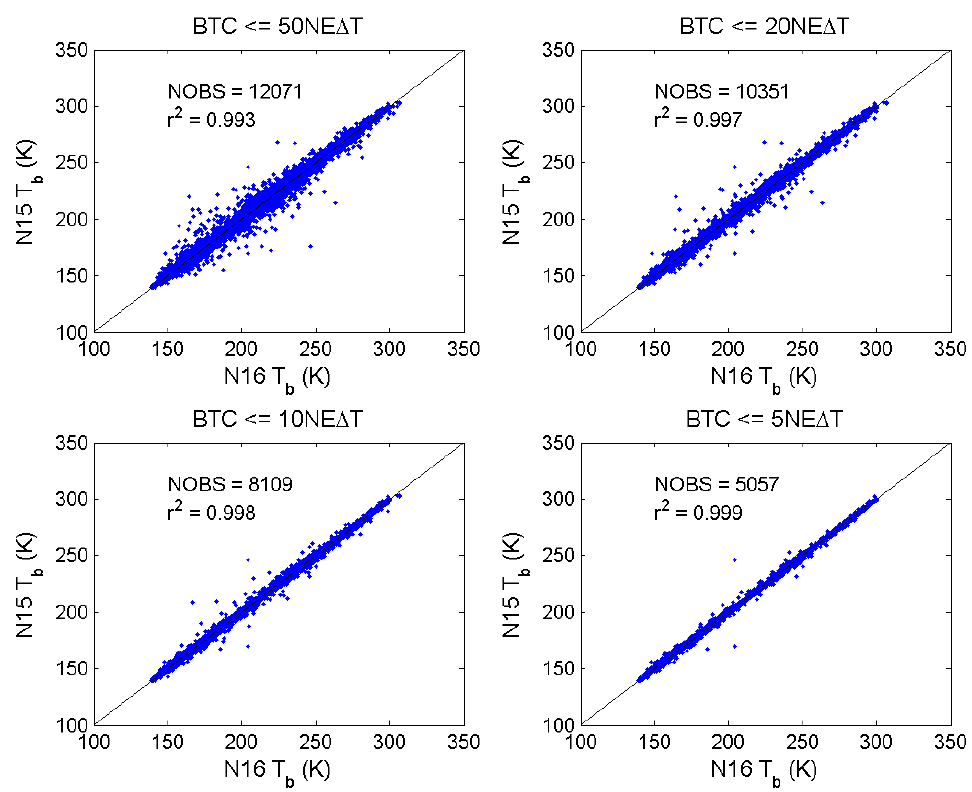
Figure 3. Scatter plot between NOAA-15 and NOAA-16 SNO brightness temperature for 23.8 GHz channel under various ranges of NE Δ T, to test the brightness temperature contrast (BTC) threshold.